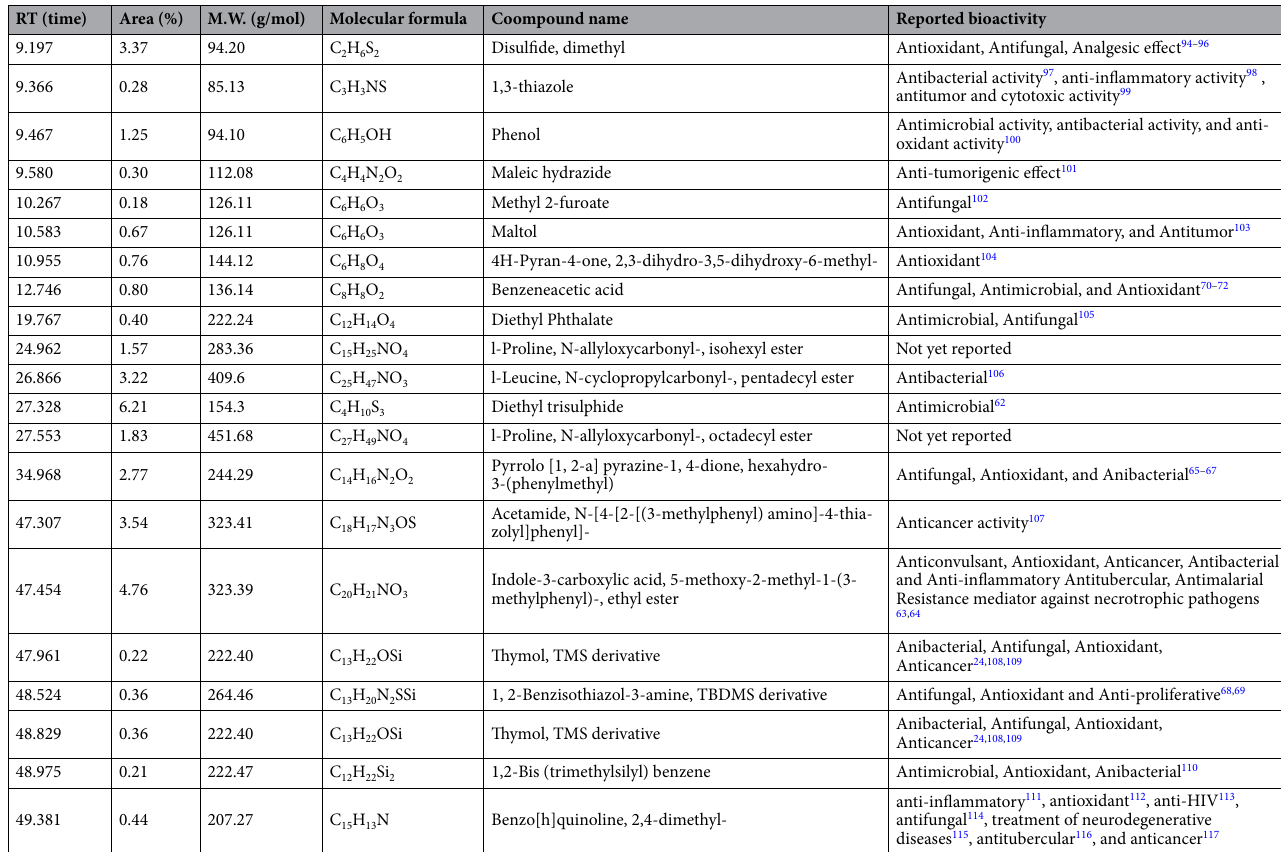
Table 8. 21 volatile compounds identified by GC–MS from dichloromethane crude extract of Streptomyces sp. E23-4 OM883990 strain. RT: Retention time; M.W.: Molecular